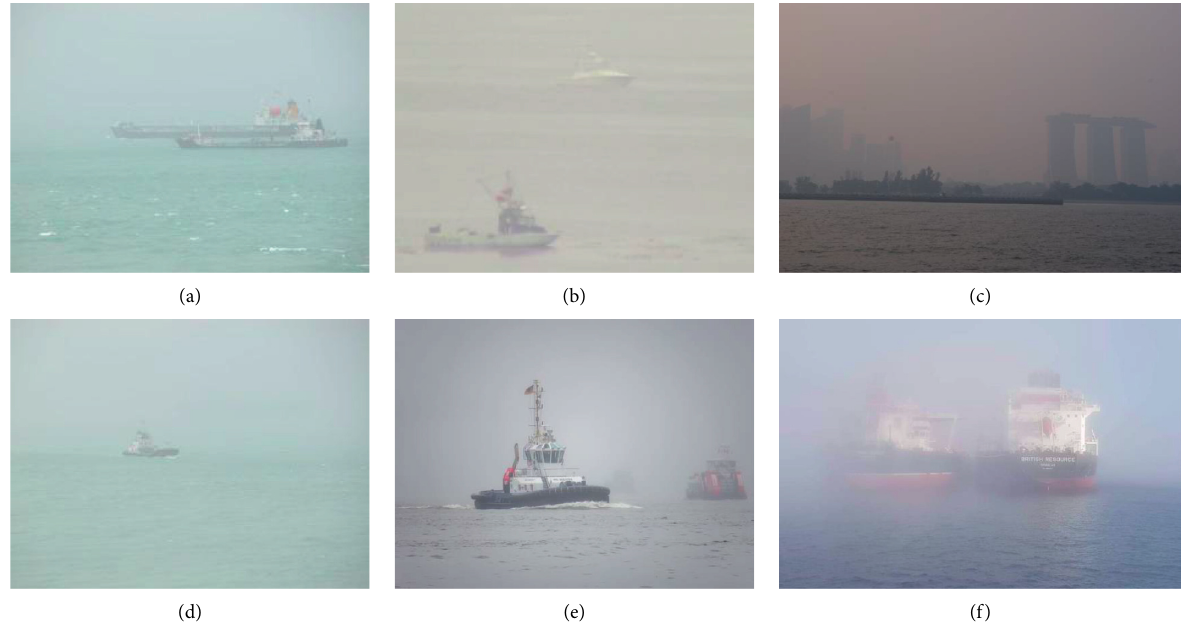
Figure 1: Maritime images captured under haze